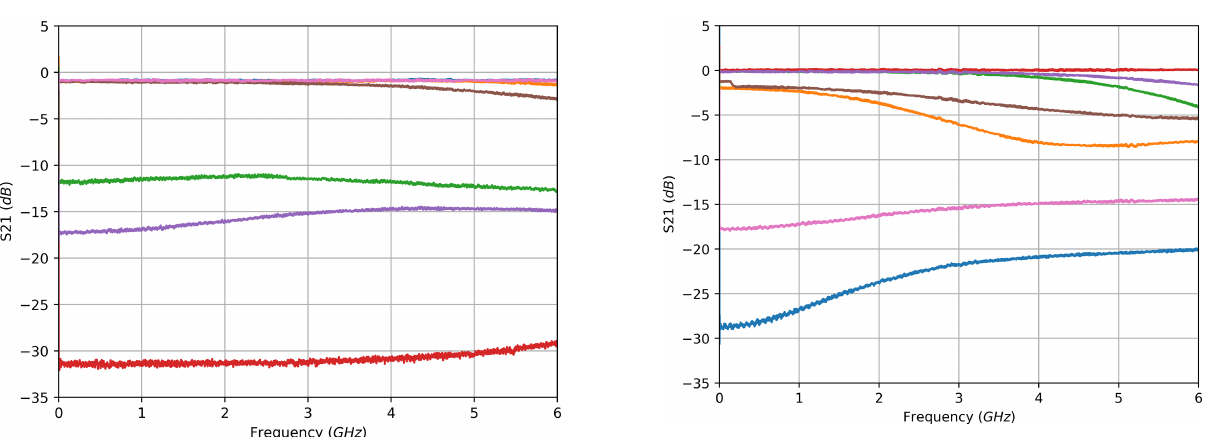
Figure 2. Electrical amplitude of S21 measurements of an FBG in transmission configuration.